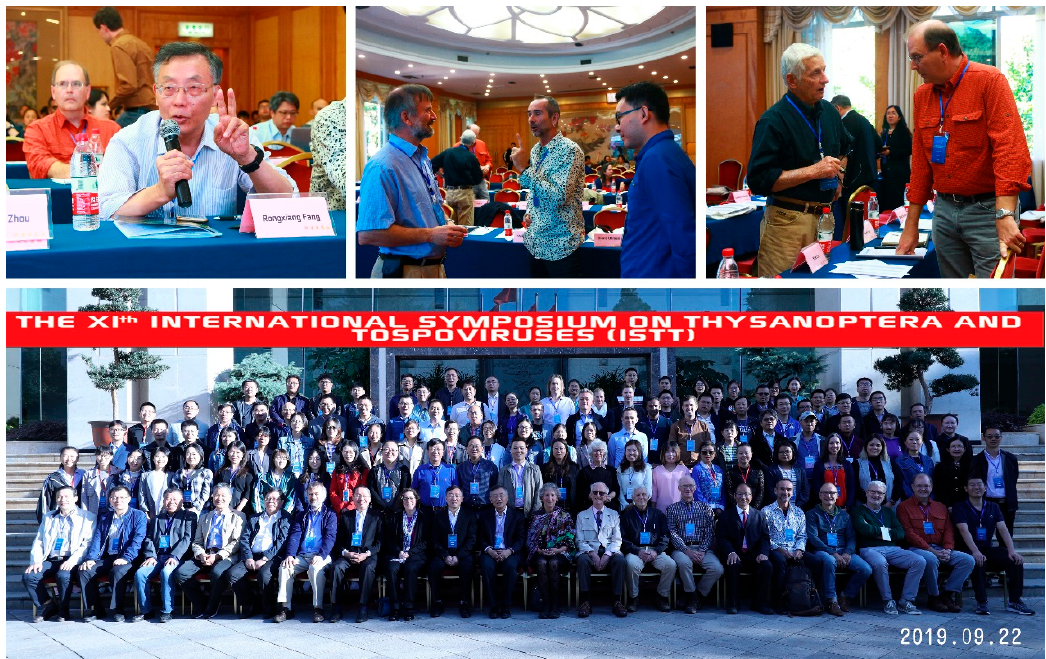
Figure 3. Group photo of representatives in the XIth International Symposium on Thysanoptera and Tospoviruses and heated discussions at the conference.